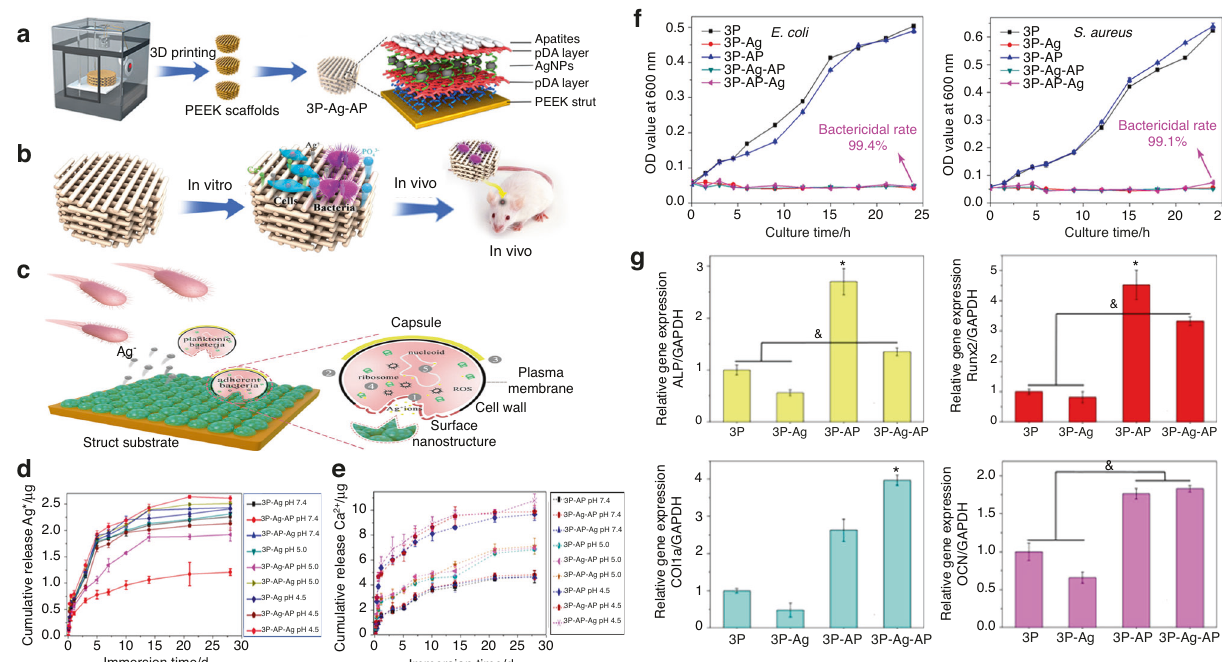
Fig. 9 Bacteria-triggered pH-responsive osteopotentiating coating on 3D-printed polyetheretherketone scaffolds for infective bone defect repair. a Scheme of the fabrication of 3P-AP-Ag coatings with pH-triggered osteopotentiating properties on 3DP porous PEEK scaffolds. b Schematic of the tests in vitro and in vivo for their multifunction. c Schematic diagram of possible antibacterial factors. Three major factors might contribute to its antibacterial properties: ROS overproduction, Ag + ion liberation, and surface nanostructure. d Delivery pro fi les of Ag + ions from different scaffolds in various pH values (pH = 7.4, 5.0, 4.5). e Delivery pro fi les of Ca 2 + ions from different scaffolds in various pH values (pH = 7.4, 5.0, 4.5). f The bactericidal curves to reveal the antibacterial activities of the coatings. g Quantitative reverse